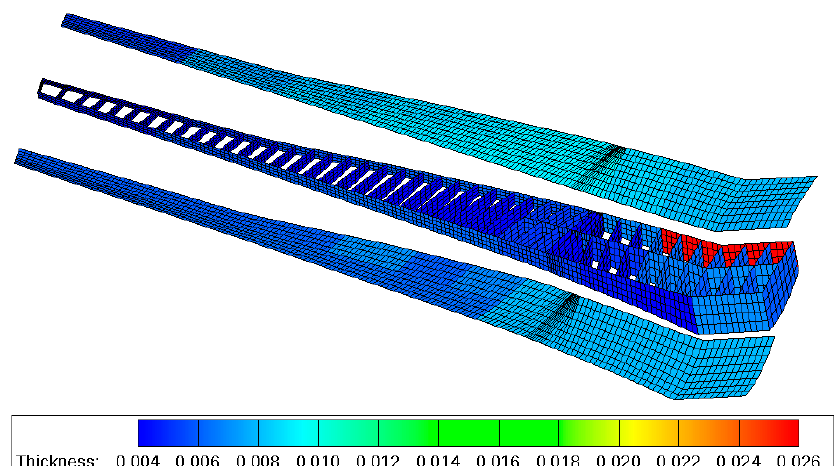
Figure 40. Sizing load cases for each design field—red. safety factor.